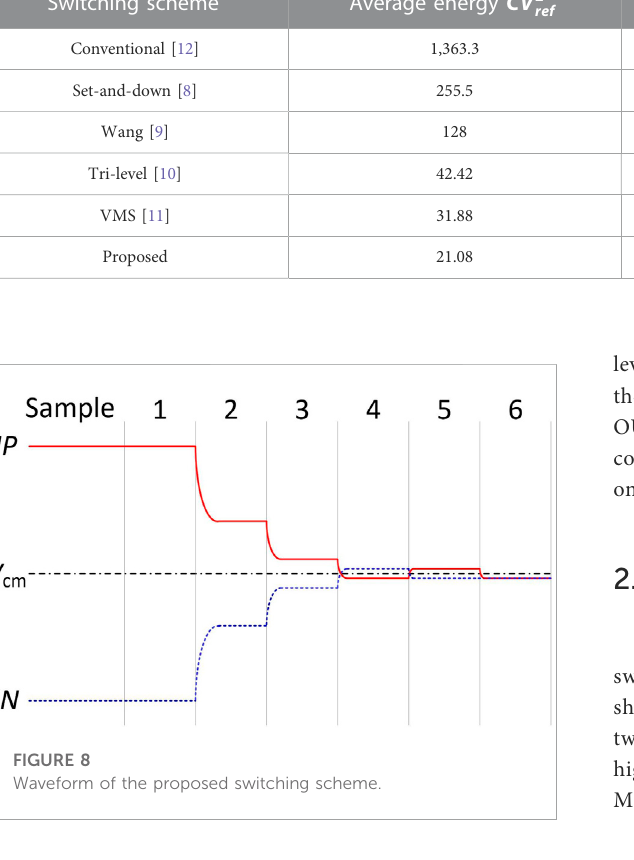
TABLE 1 Comparison of energy saving and Common-mode shift for different switching schemes of a 10-bit SAR ADC. Switching scheme